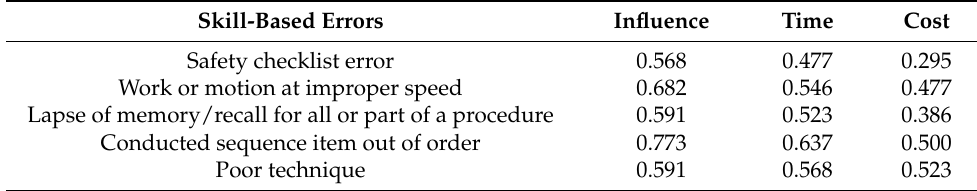
Table 4. Fuzzy decision matrices of skill-based errors.